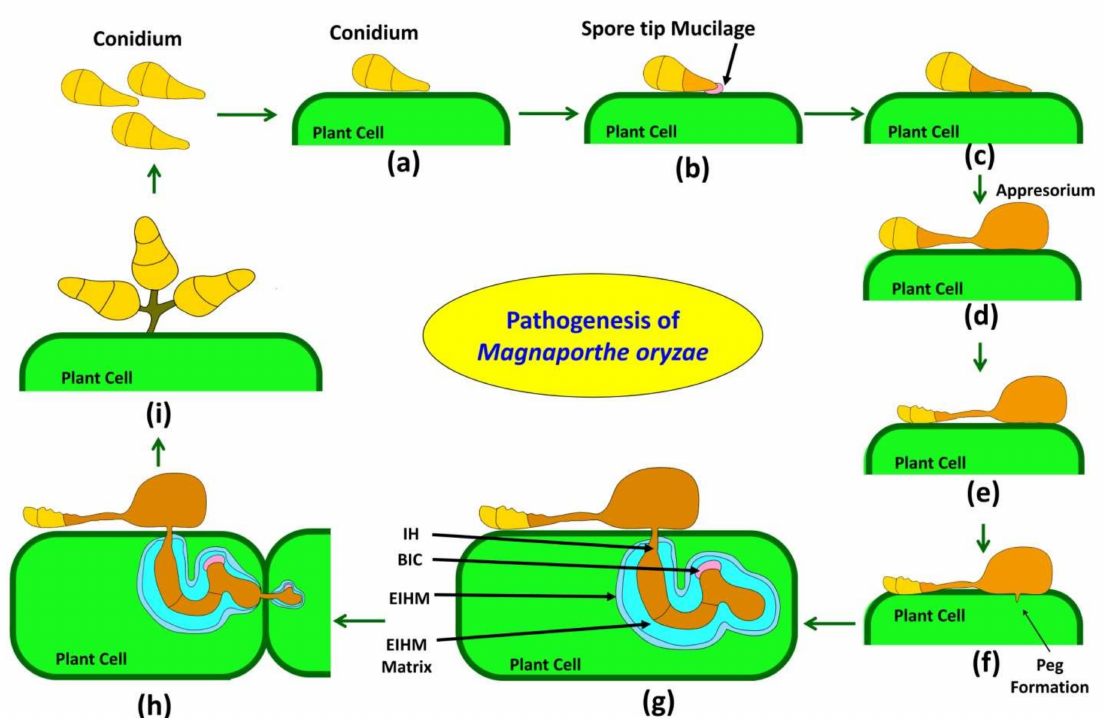
Figure 1. Pathogenesis of the rice blast fungus Magnaporthe oryzae . ( a ). Infection of the rice blast fungus starts when a three-celled conidium lands on the rice leaf surface. ( b ). Spore tip